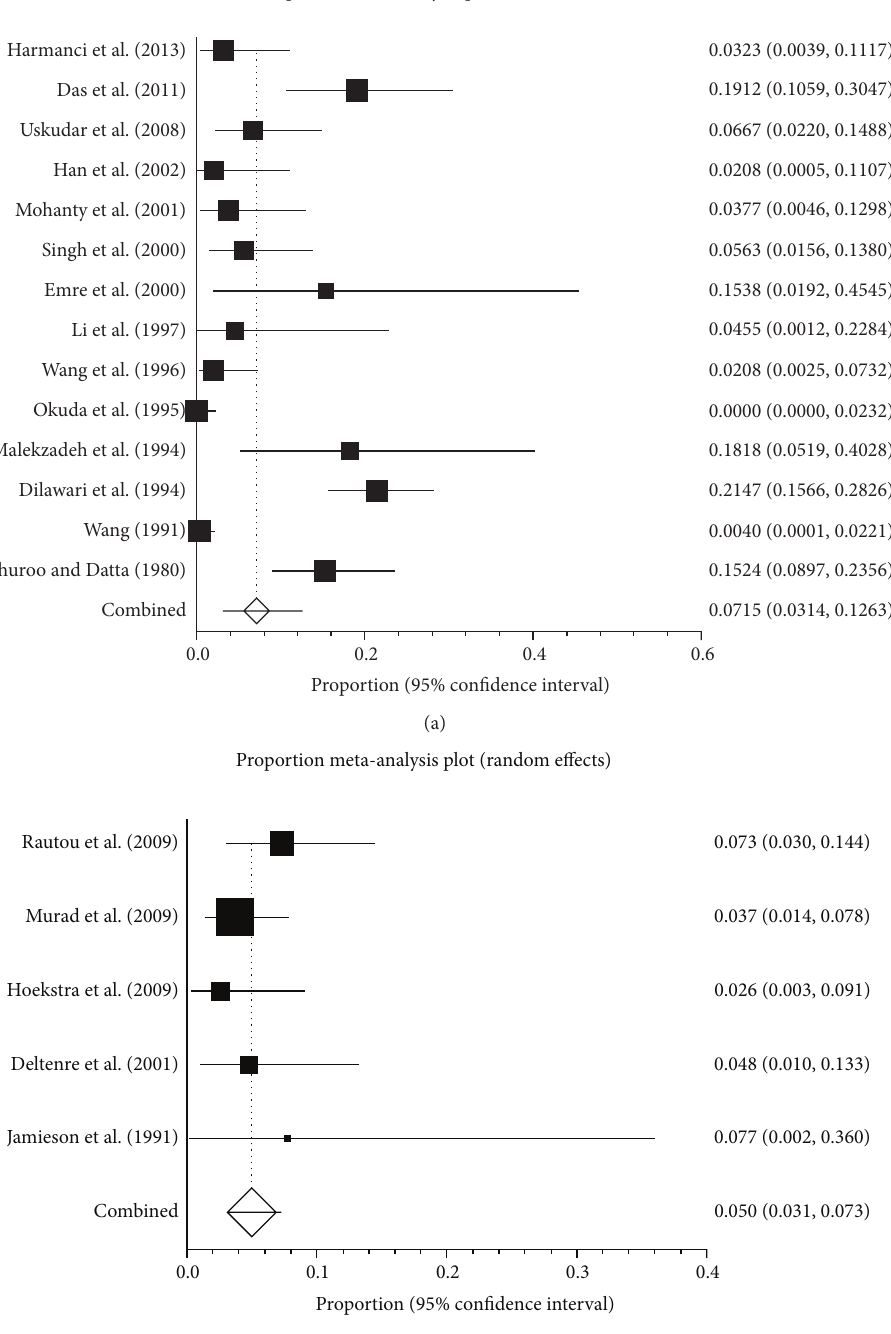
Figure 4: Forest plots of prevalence of pregnancy-related BCS in Asian (a) and European studies (b).